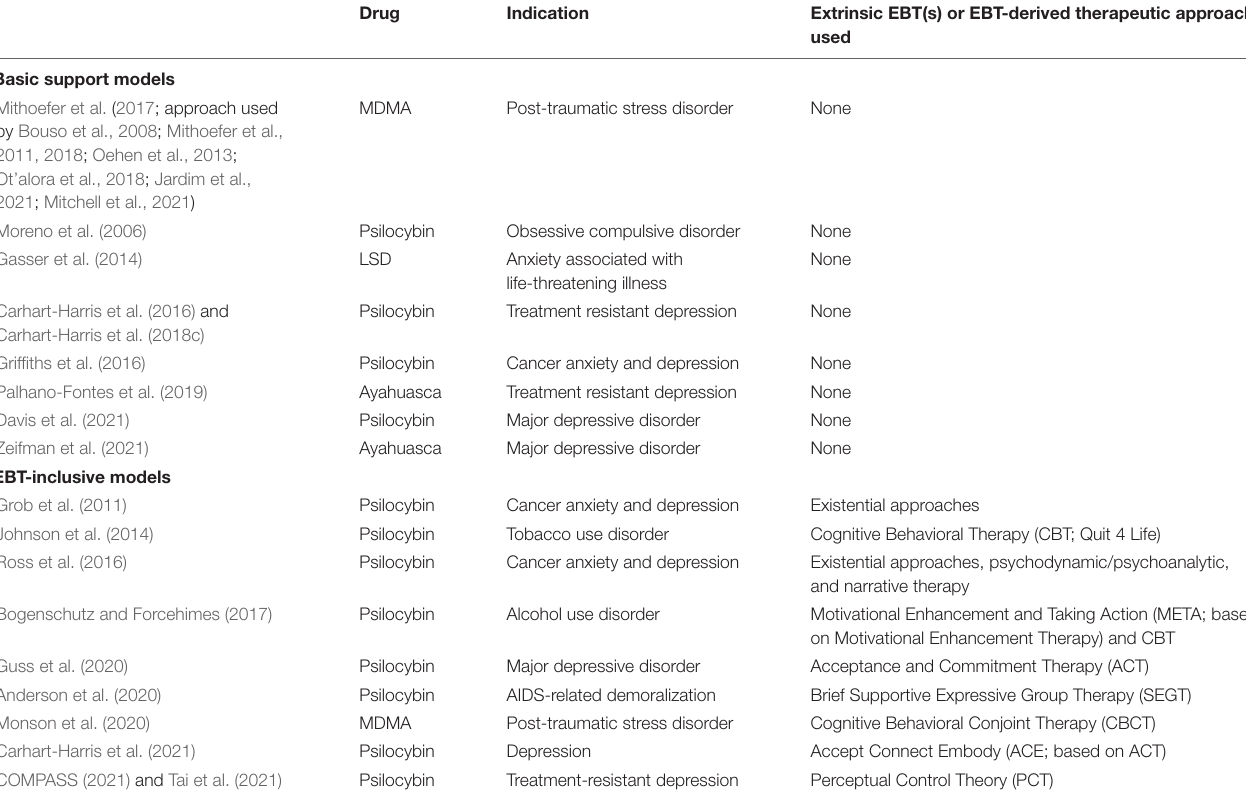
TABLE 1 | Existing models of psychedelic-assisted psychotherapy.